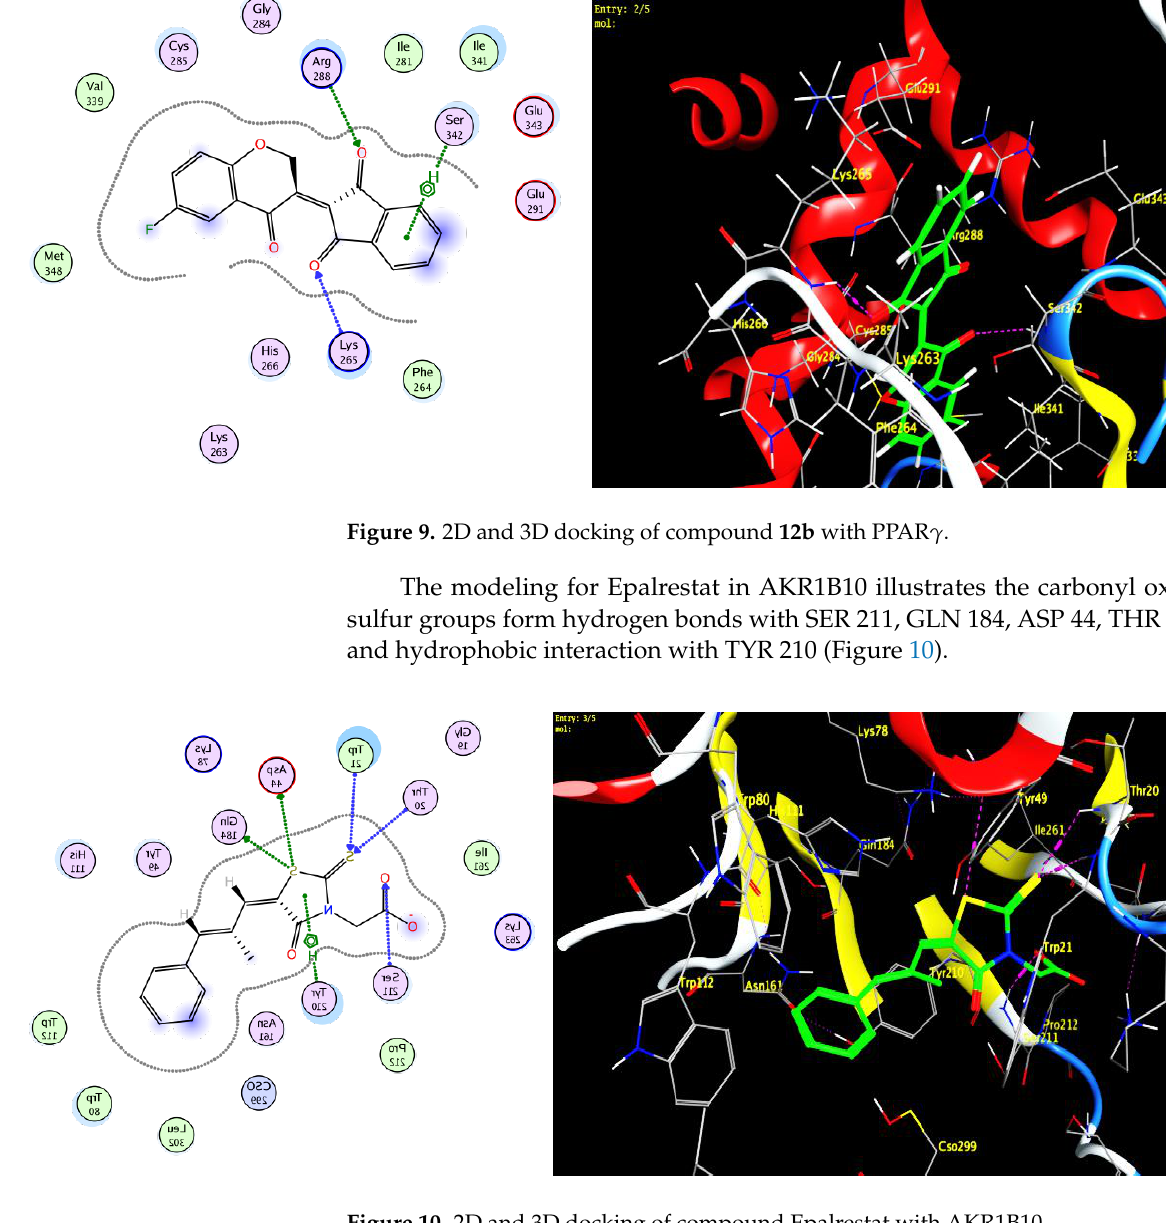
Figure 10. 2D and 3D docking of compound Epalrestat with AKR1B10.